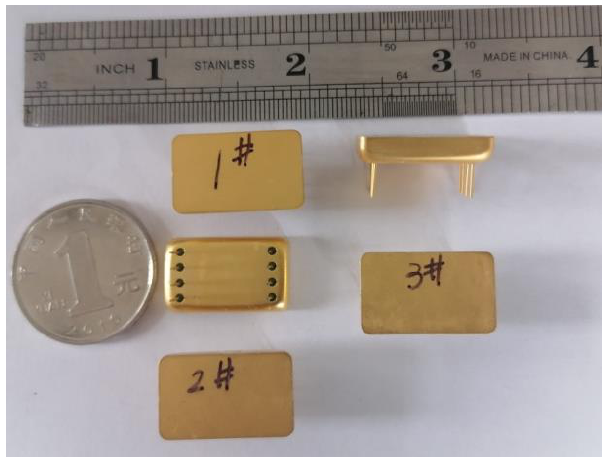
Figure 12. Metal encapsulated sensor.